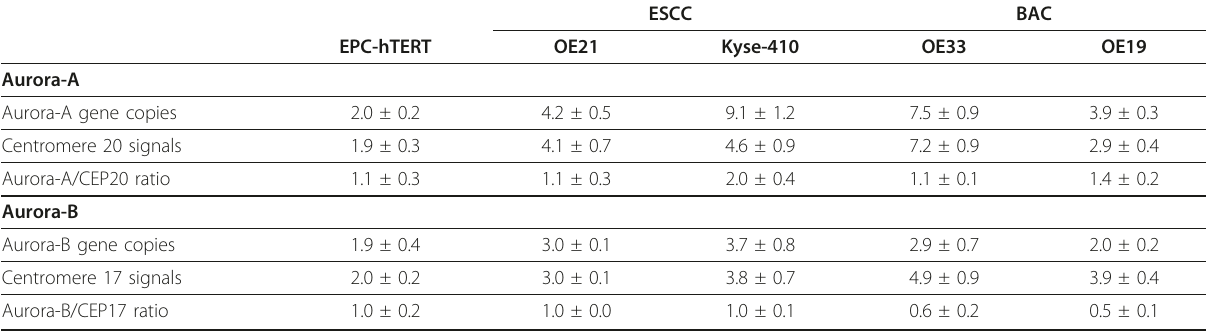
The table summarizes results of FISH analyses of control esophageal epithelial cells (EPC-hTERT) and all four esophageal cancer cell lines, with mean and ± standard deviation of gene specific (Aurora-A, Aurora-B) and centromere (CEP, chromosome enumeration probe) specific FISH signals as well as the amplification status (gene to centromere ratio: Aurora-A to CEP20; Aurora-B to